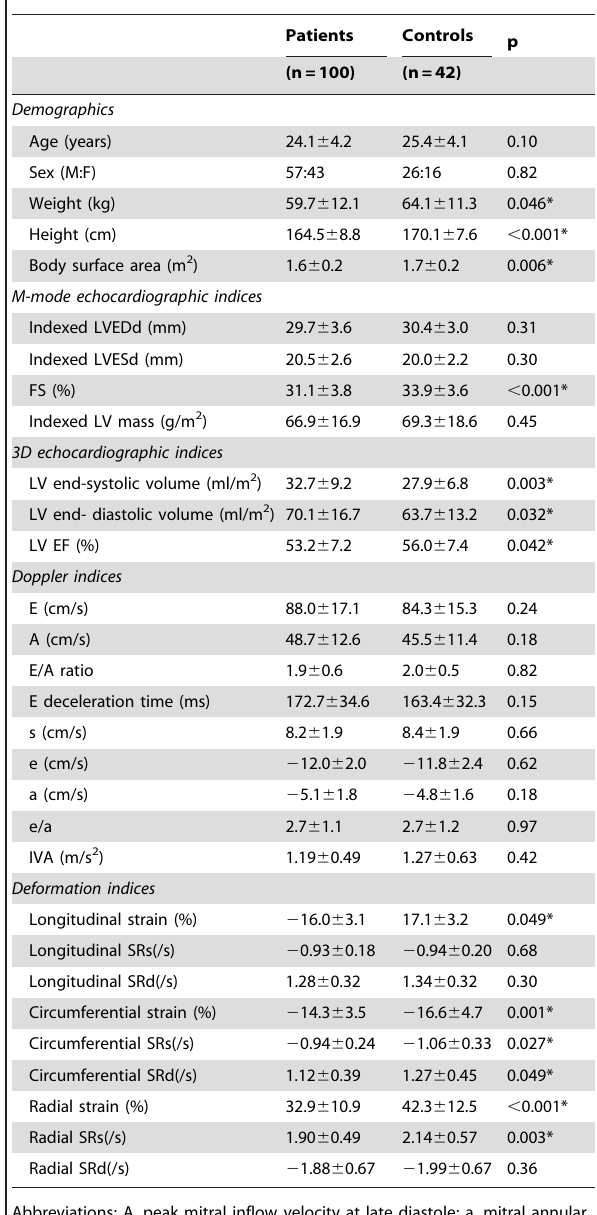
Table 1. Comparisons of demographic and echocardiographic findings between survivors and control